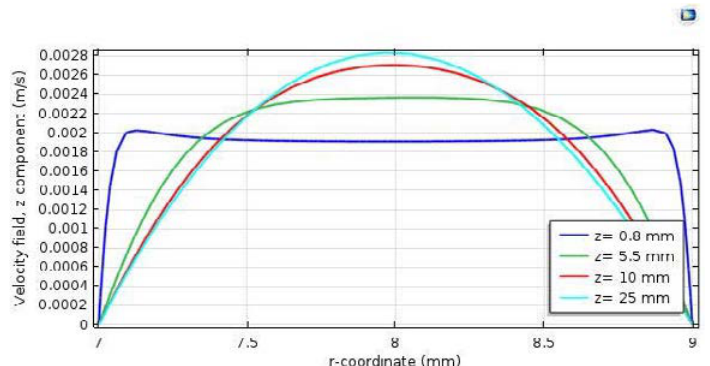
Fig. 12: Velocity profile vs. r-coordinate at various membrane lengths (0.5 l/min feed flow rate and 30°C temperature)